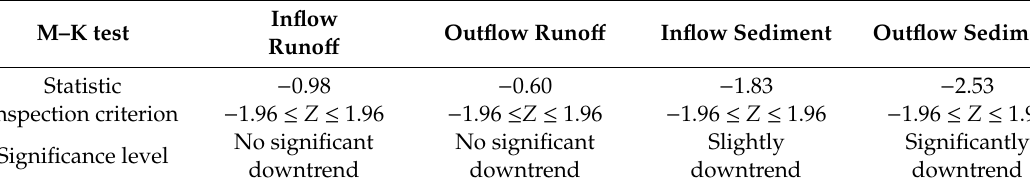
Table 1. The runoff and sediment (Mann-Kendall) M–K statistic of flowing into and out of Hongze Lake.